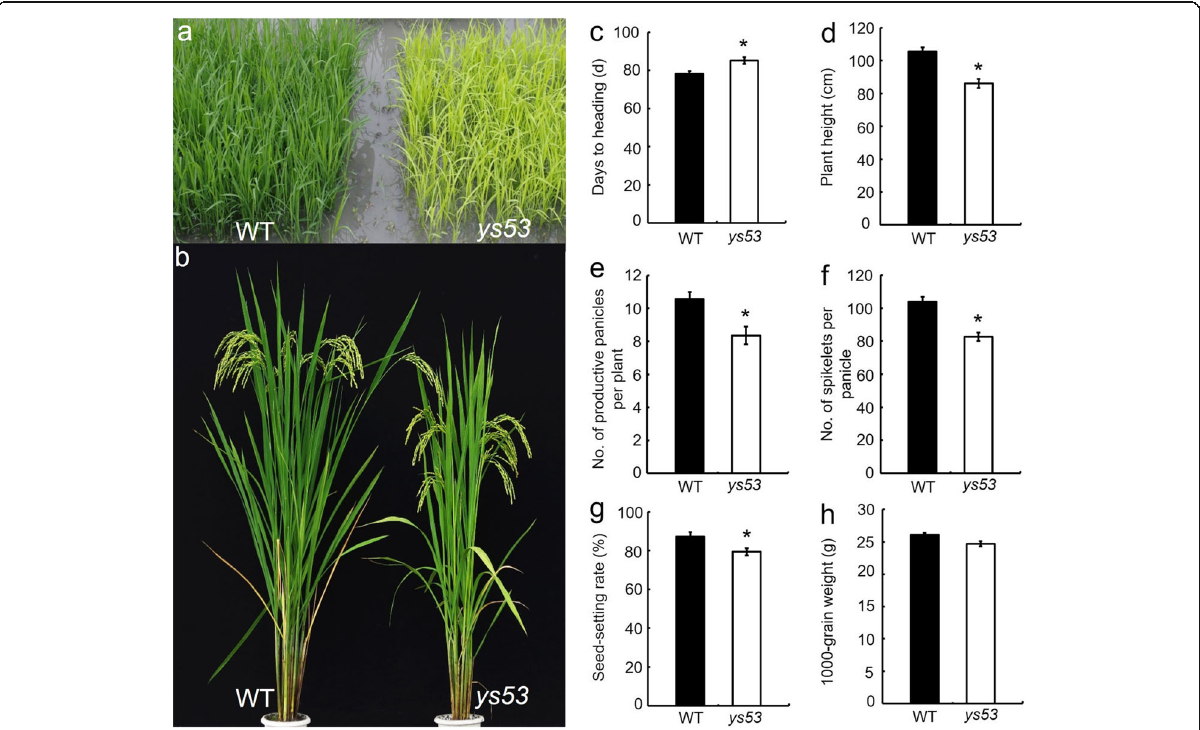
Fig. 1 Comparison of plant phenotypes and major agronomical traits of the ys53 mutant and its wild-type parent Nipponbare (WT). a Plant Phenotype at seedling stage. b Plant Phenotype at grain-filling stage. c Days to heading. d Plant height. e No. of productive panicles per plant. f No. of spikelets per panicle. g Seed-setting rate. h 1000-grain weight. Bars represent standard deviations (SDs) of three independent measurements. * signify statistically significant differences compared to the wild type at P <